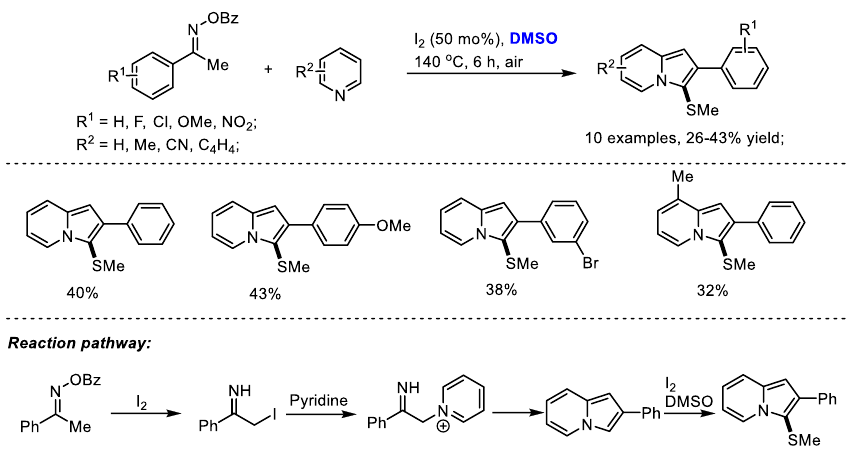
Molecules 2022 , 27 , x FOR PEER REVIEW Scheme 22. DMSO/SOCl 2 -promoted synthesis of 3-methylthioindoles [35]. Scheme 22. DMSO/SOCl 2 -promoted synthesis of 3-methylthioindoles [35].